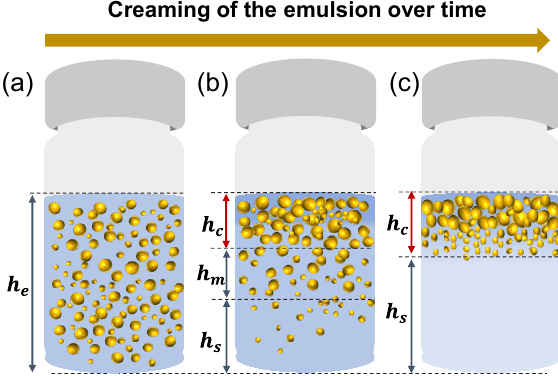
Figure 1. Representation of the creaming of an O/W emulsion over time. (a) First, the oil is dispersed into the aqueous phase, resulting in . (b) With time, the a homogeneous O/W emulsion of initial height emulsion becomes physically unstable, and the oil progressively ℎ 𝑒𝑒 ascend to the top of the emulsion, identifying three layers: a serum ), a middle ( ), and a creamed ( ) layer. (c) In the end, the ( continuous and disperse phases of the emulsion are completely ℎ 𝑚𝑚 ℎ 𝑐𝑐 ℎ 𝑠𝑠 ) and a creamed ( ) separated in a serum ( ℎ 𝑐𝑐 ℎ 𝑠𝑠